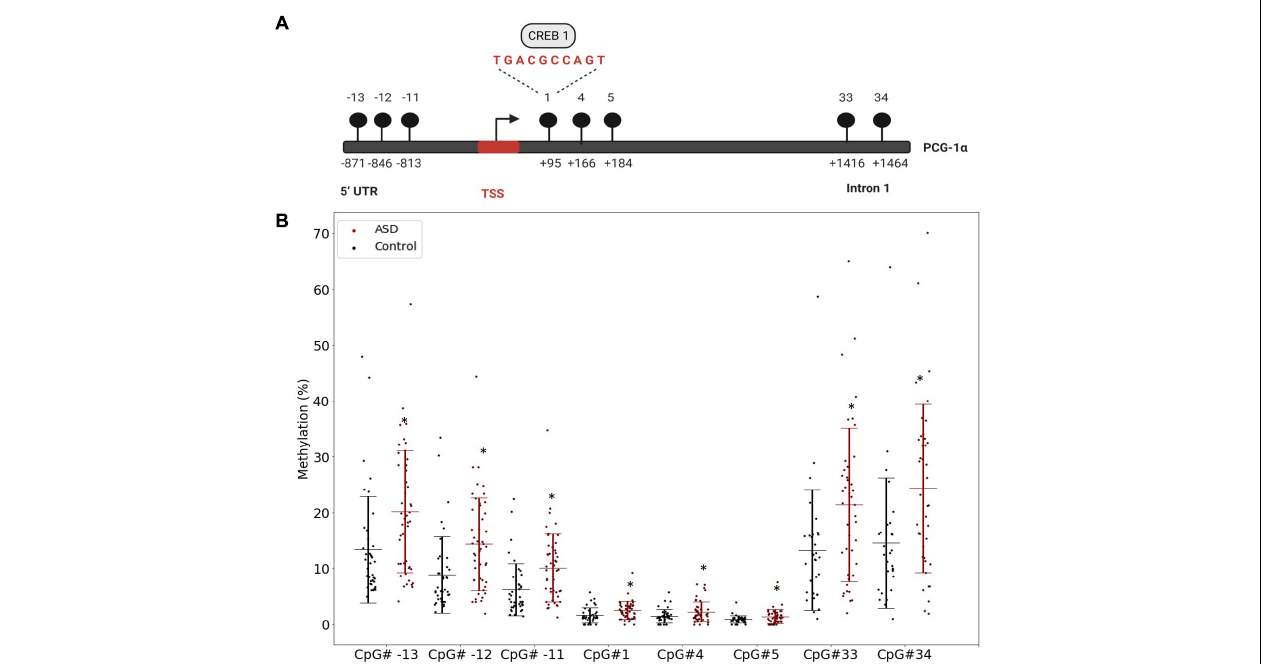
Frontiers in Cell and Developmental Biology |